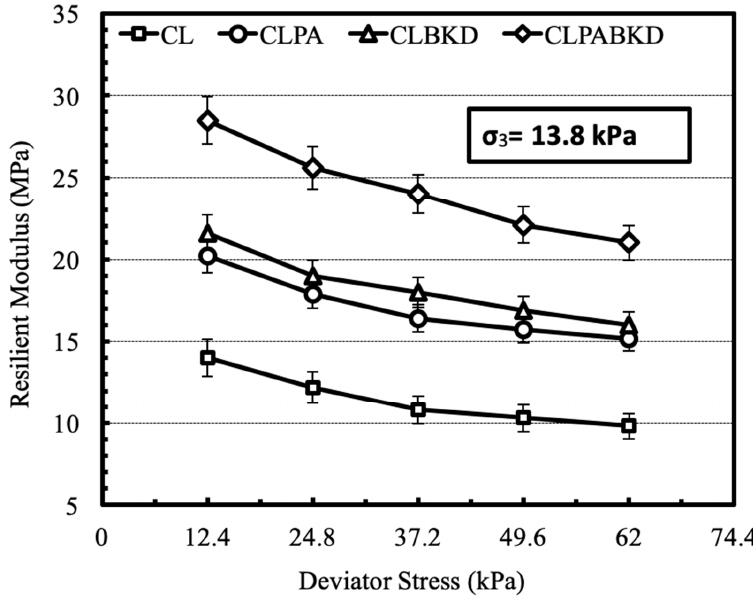
Figure 14. Variation in M R of optimum mixtures (soaked) with cyclic deviator stress at a confining pressure of 13.8 kPa.